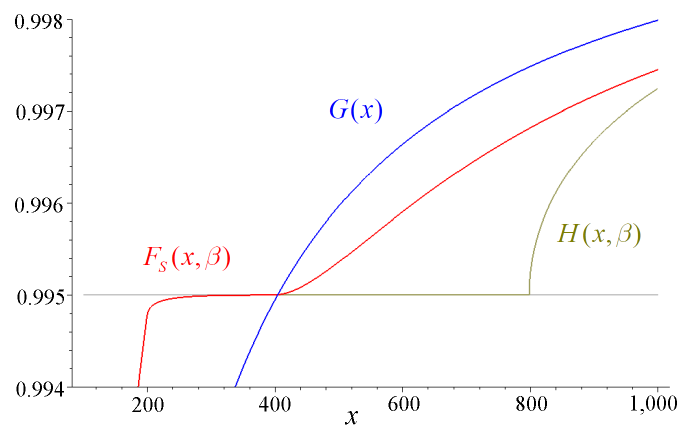
Figure 12: Plots of the cdf’s F S ( x , β ) , G ( x ) and H ( x , β ) for β = 0.005 in Example 3.